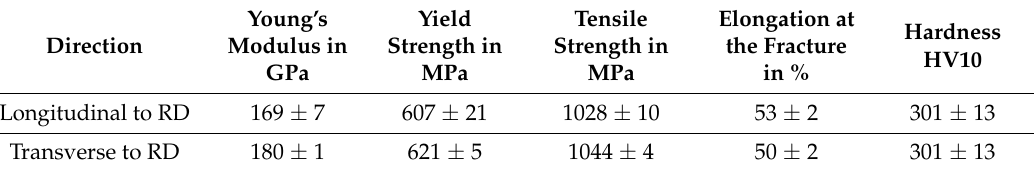
Table 2. Mechanical properties of the HSD ® 600 steel (RD: rolling direction).